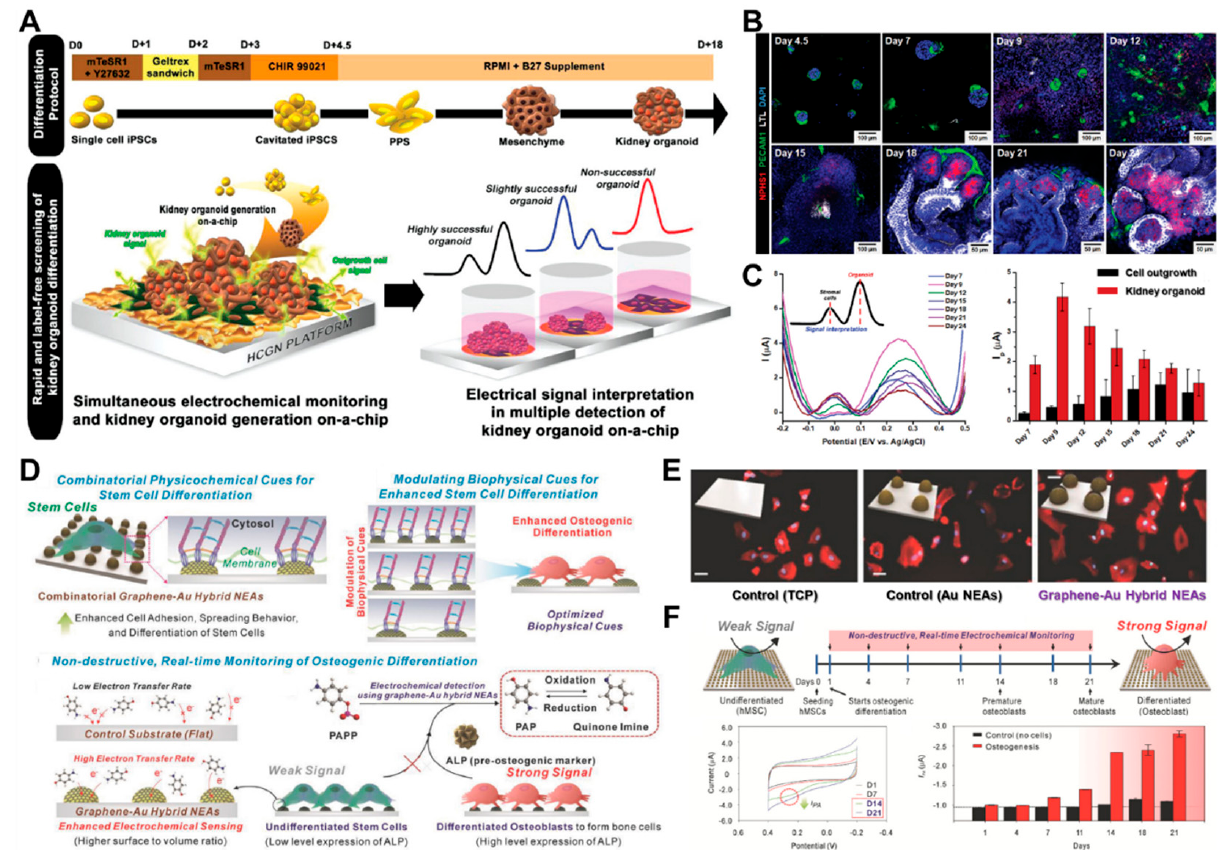
Figure 6. ( A ) Non ‐ invasive monitoring of a kidney organoid on ‐ a ‐ chip using an electrochemical method Figure 6. ( A ) Non-invasive monitoring of a kidney organoid on-a-chip using an electrochemical for the detection of its successful and label ‐ free differentiation. ( B ) Representative time ‐ dependent images method for the detection of its successful and label-free differentiation. ( B ) Representative time- of NPHS1s (podocytes), LTLs (proximal tubules), and PECAM1s (vascular networks) during the kidney dependent images of NPHS1s (podocytes), LTLs (proximal tubules), and PECAM1s (vascular net- works) during the kidney organoid differentiation. ( C ) Differential pulse voltammetry (DPV) graph of the kidney organoid differentiation from day 7 to day 24 (black bar, cell outgrowth; red bar,